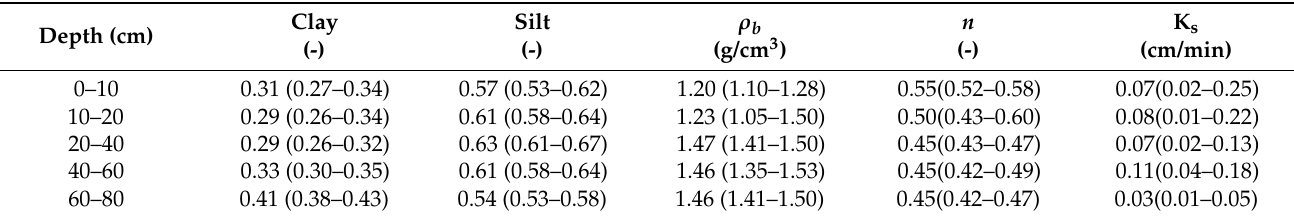
Table 1. Average values of grain composition, physical properties, and saturated hydraulic con- ductivities of five depths in the experimental field. Range is in parentheses (minimum/maximum